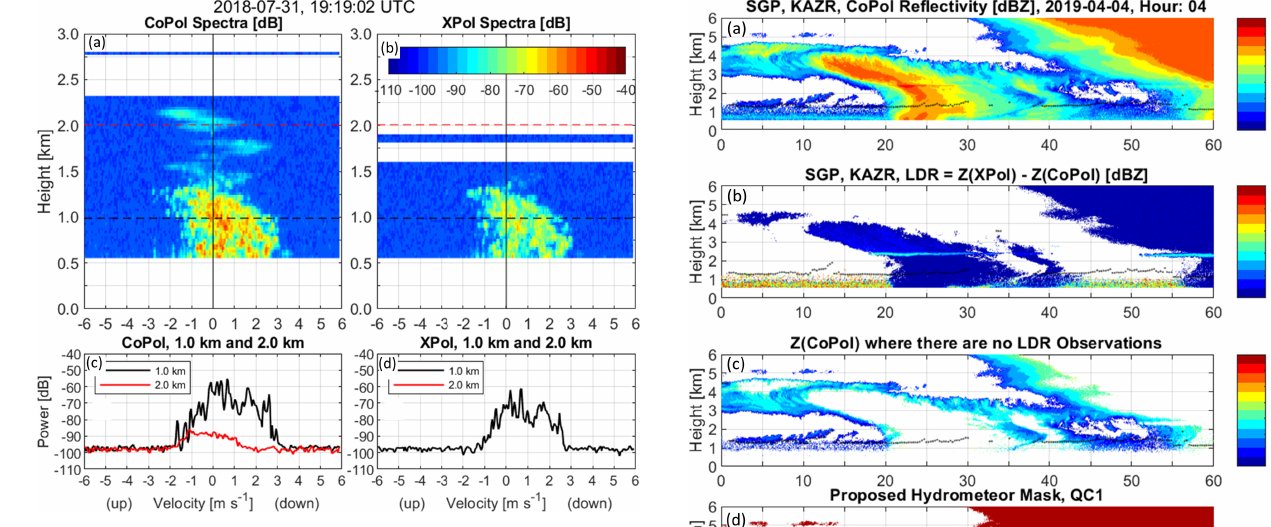
Figure 3. Spectra from the profile at 19:19:02UTC on 31 July 2018. (a) CoPol Doppler velocity power spectra (dB) as a function of range and radial velocity. (b) XPol Doppler velocity power spectra (dB) as a function of range and radial velocity. (c) CoPol Doppler velocity power spectra at 1.0km (black line) and 2.0km (red line). (d) XPol Doppler velocity power spectra at 1.0km (black line).